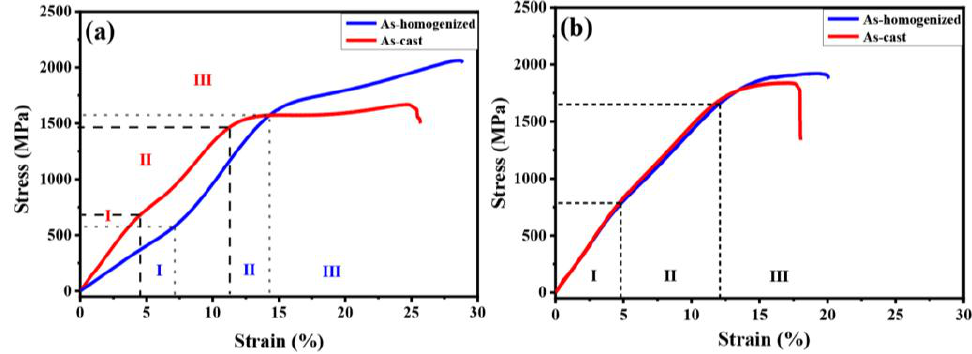
Figure 4. Compressive stress–strain curves of ( a ) Cu15HZ25 and ( b ) Cu15HZ30 in as-cast and as-homogenized states. Table 3. Mechanical properties of as-cast and as-homogenized states of Cu15HZ25 and Cu15HZ30.